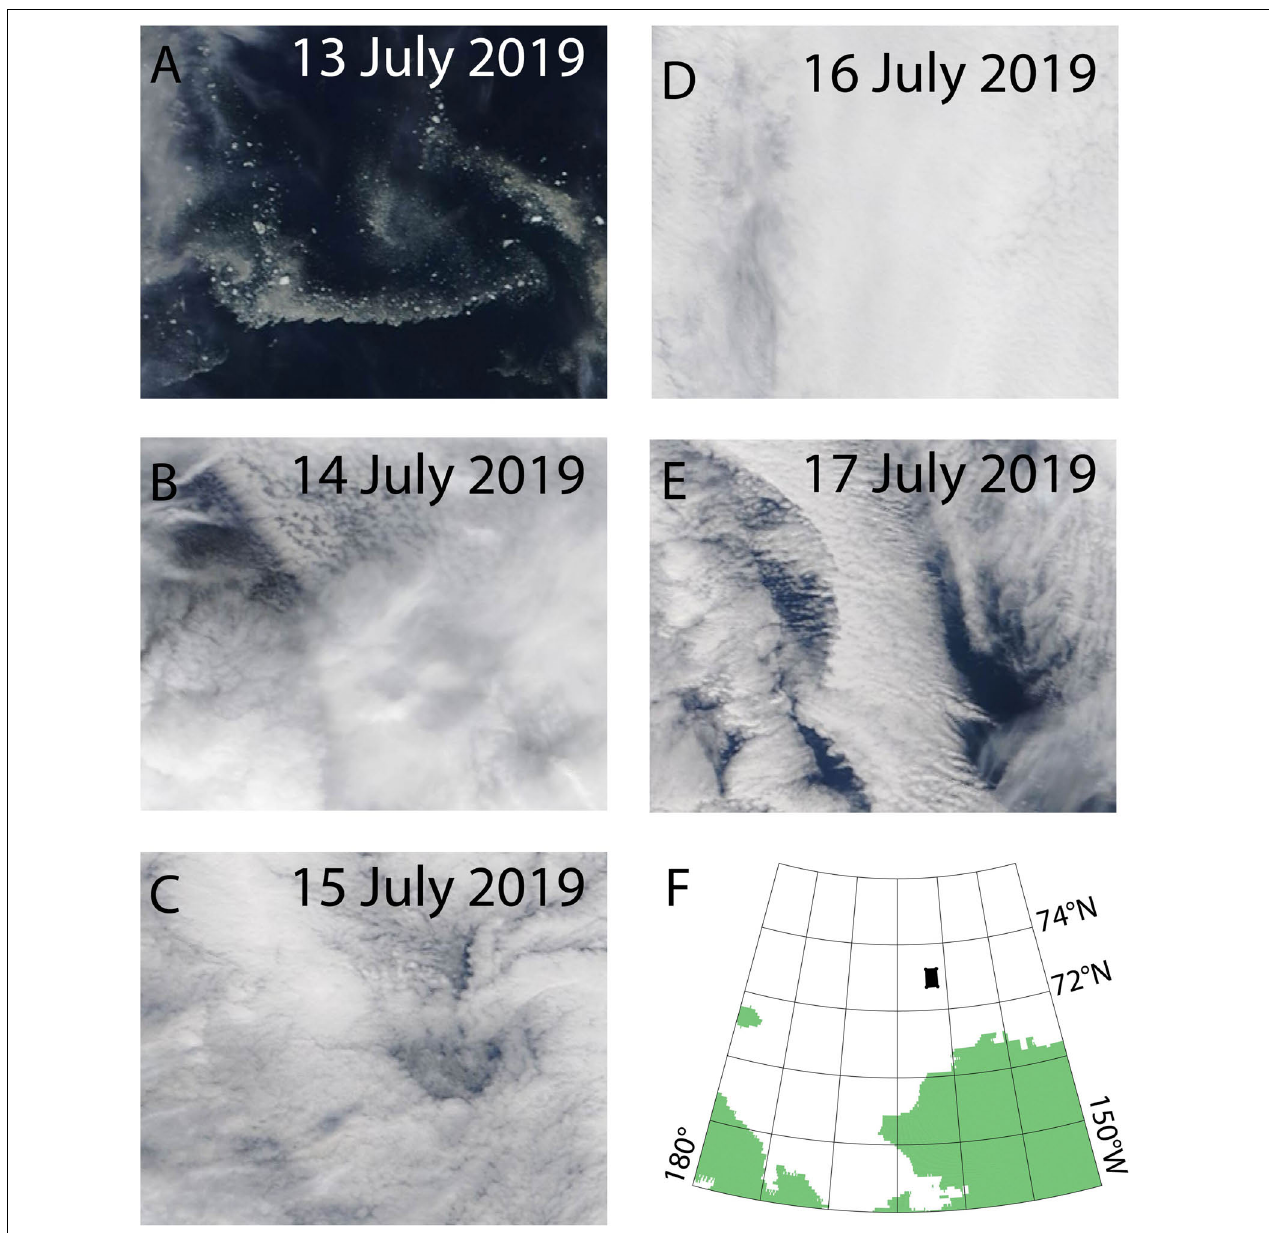
FIGURE 8 | Daily “natural color” images from the MODIS instrument aboard the Terra satellite. These images are centered at 161.46W, 72.97N and span approximately 60 km meridionally (vertical) and 18 km zonally (horizontal). The ice edge visible in panel (A) was targeted for exploration on 13 July 2019, but skies remained cloudy from 14 July through contact with the remnants of the band in the first hour (UTC) of 18 July panels (B–E) . The black rectangle in panel (F) shows the location of the images.